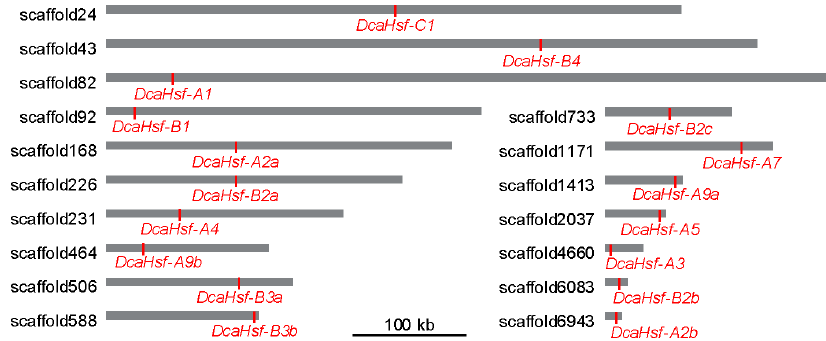
Figure 1. Scaffold locations of DcaHsfs . Bars represent the scaffolds, DcaHsfs are marked by redlines.